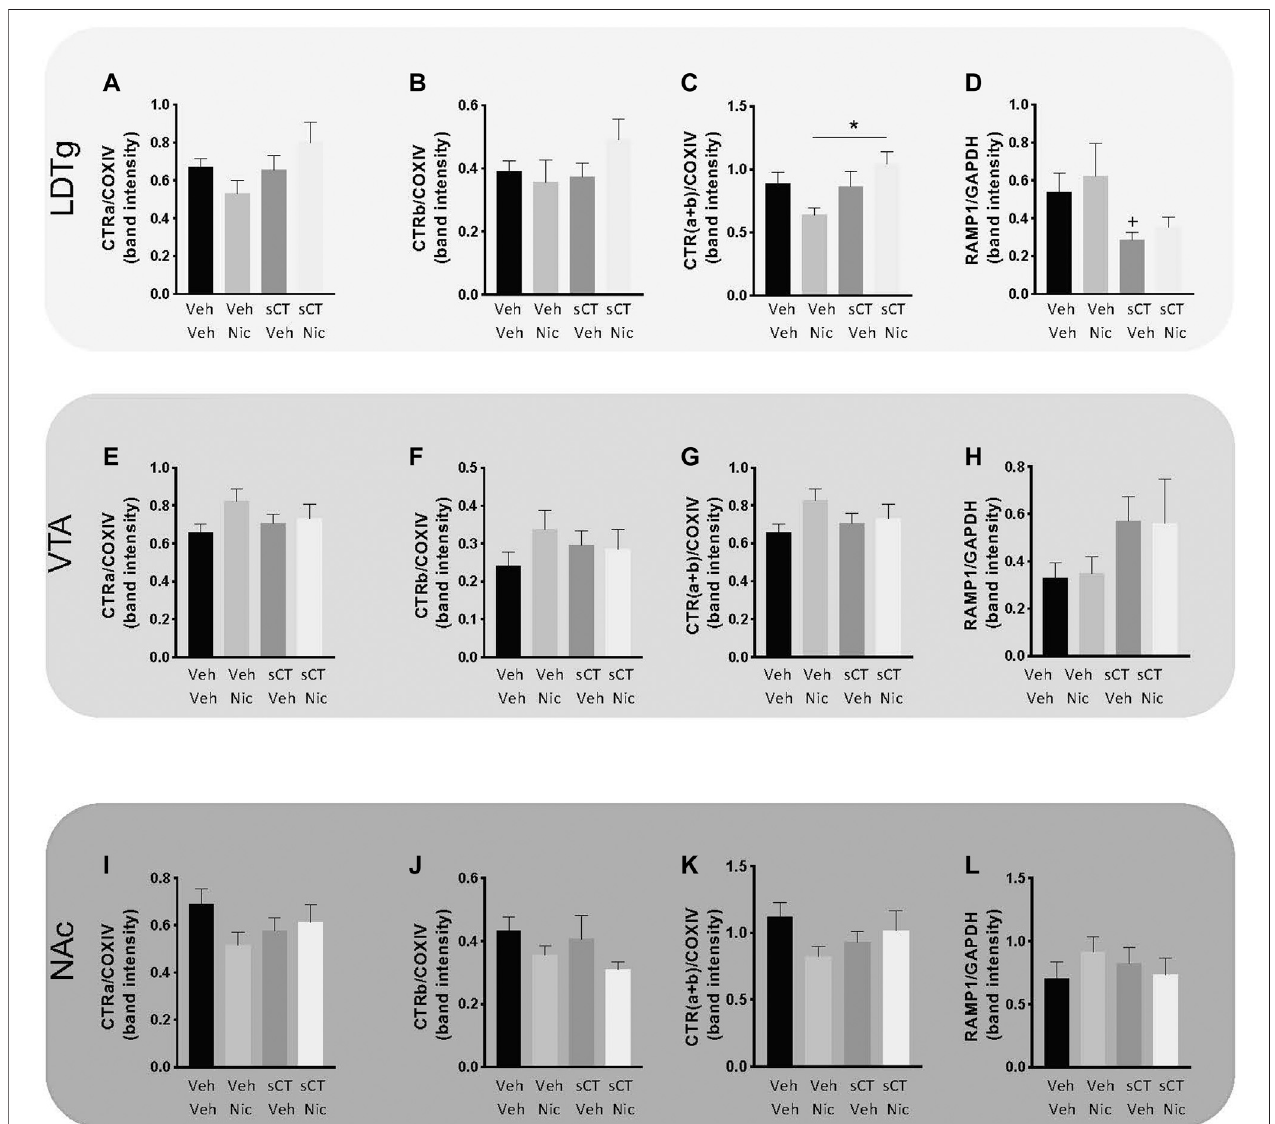
FIGURE 3 | Effects of repeated sCT and nicotine administration on the levels of CTRa, CTRb, CTR (a + b) and RAMP1 in reward-related brain areas in male mice from the locomotor sensitisation experiment. In the laterodorsal tegmental area (LDTg) no effect of treatment was noted on the protein levels of normalized (A) CTRa or (B) CTRb (C) However,theproteinlevelsoftotalCTR(a+b)werehigherinthesCT-nicotinegroupcomparedtothevehicle-nicotinegroup(* p < 0.05) (D) Nooveralleffect of treatment was noted on the protein levels of normalized RAMP1 in the LDTg. However, sub-analysis shows that sCT treatment reduces RAMP1 compared to vehicle (+ p < 0.05, Mann-Whitney test). In the ventral tegmental area (VTA), no effect of treatment was noted on the protein levels of normalized (E) CTRa, (F) CTRb, (G) total CTR (a + b) or (H) RAMP1. In the nucleus accumbens (NAc), no effect of treatment was noted on the protein levels of normalized (I) CTRa, (J) CTRb, (K) total CTR (a + b) or (L) RAMP1. Data are presented as mean ± SEM.